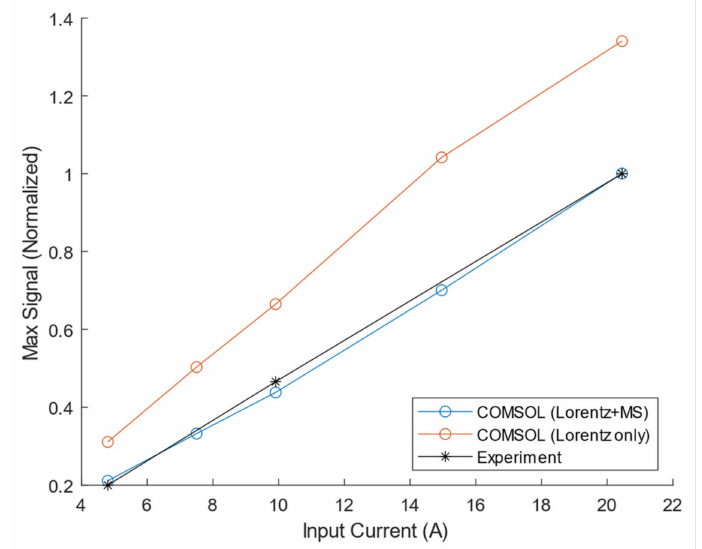
Figure 14. Simulated (either Lorentz only or combined Lorentz and magnetostriction) and Experi- mental PPM-to-PPM Maximum Receiver Voltage on Steel Plate vs. Input